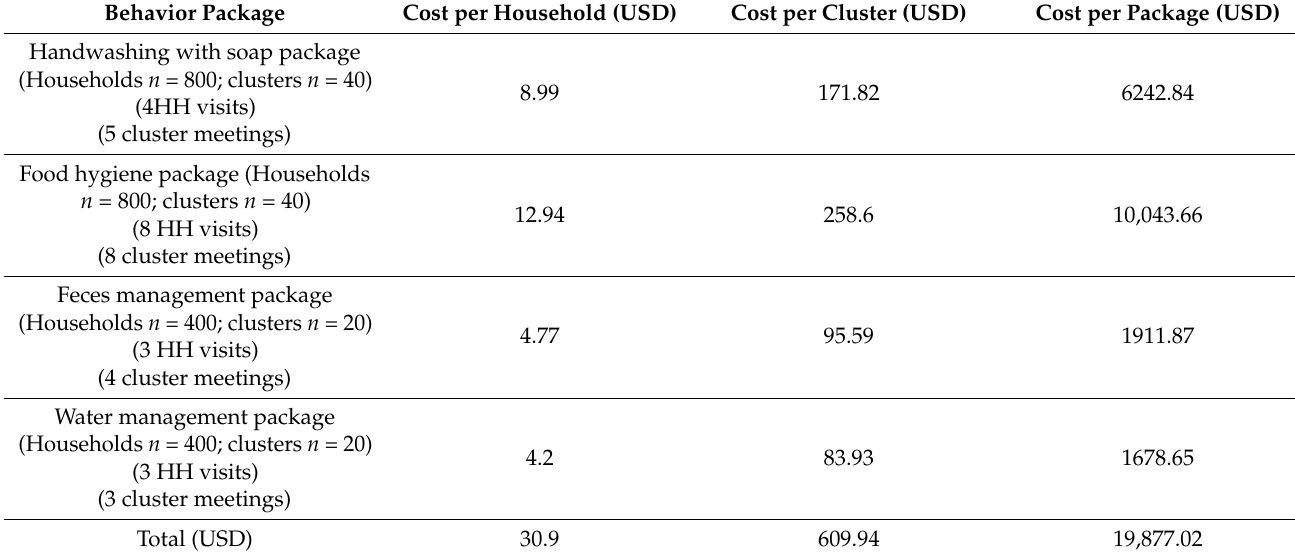
Table 6. Overall estimated delivery cost for 36-week Hygienic Family intervention (US